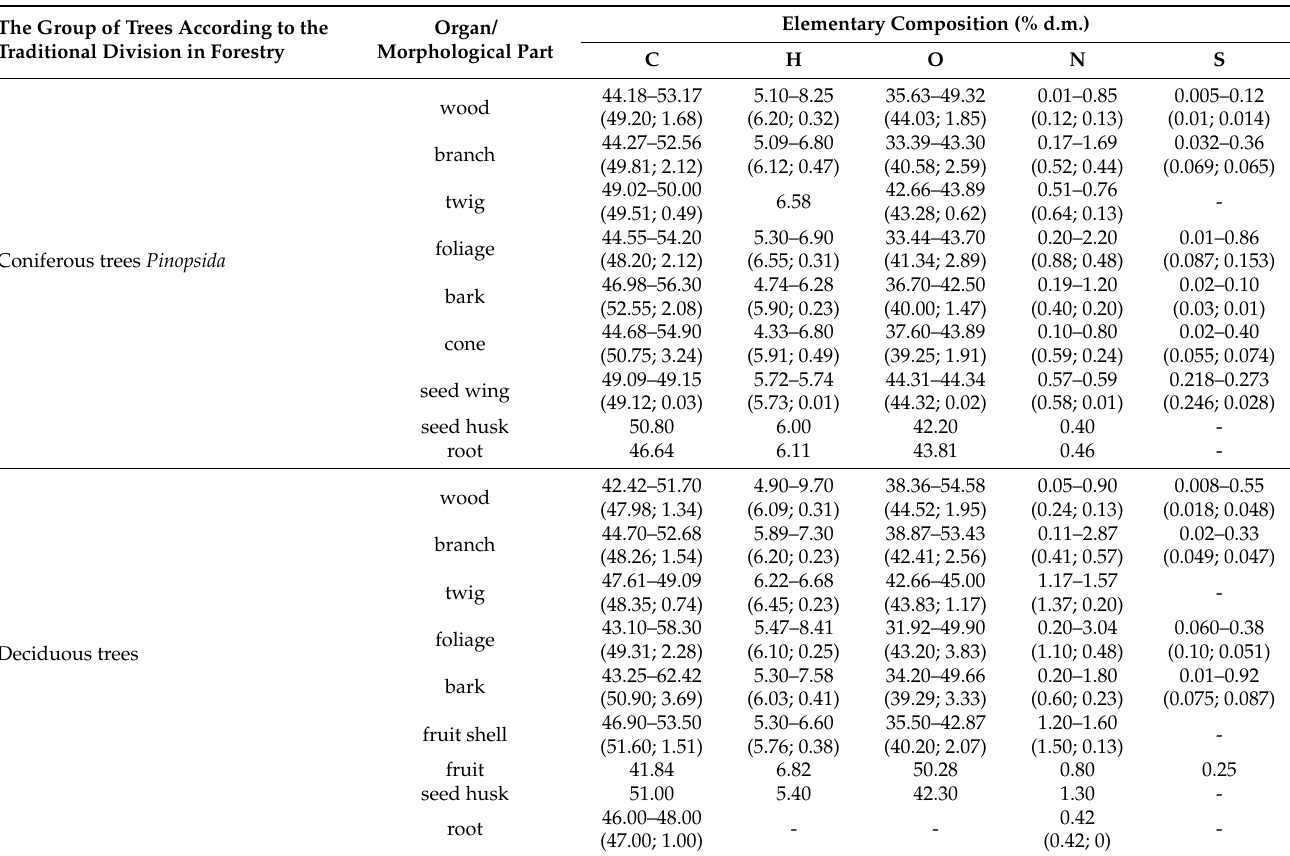
Table A5. Elementary composition/ultimate analyses of particular organs of coniferous and decidu- ous